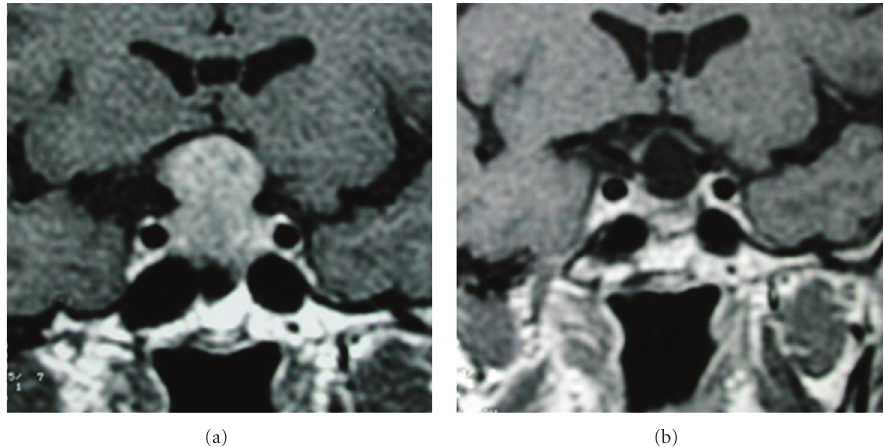
Figure 4: Typical “snowman” or “dumbbell” shape appearance of a pituitary adenoma causing acromegaly. In this case, even though the tumor was macroscopically removed, the patient was not cured with surgery and had to be medically treated. (a) Preoperative imaging and (b) postoperative